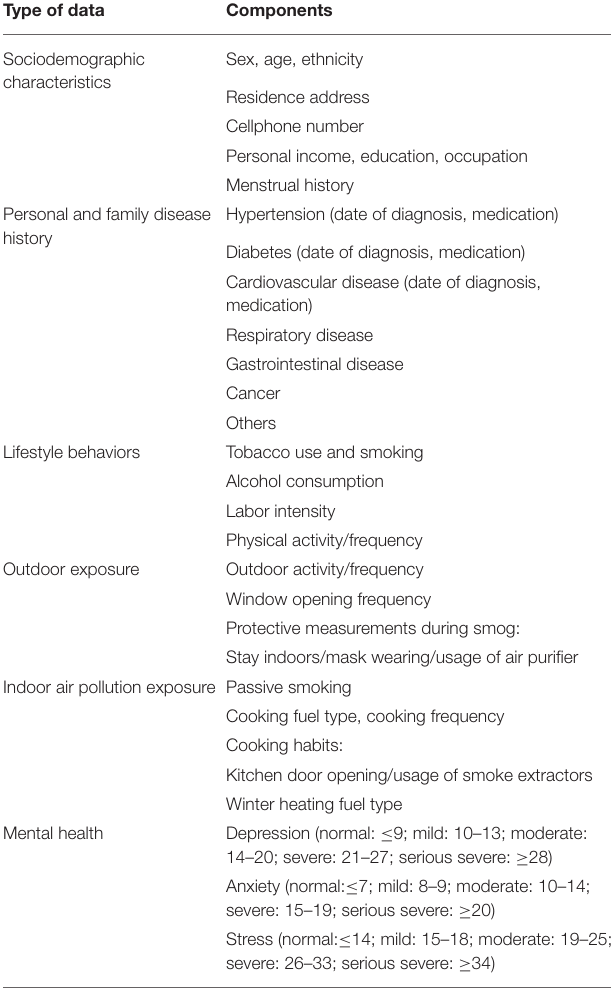
TABLE 2 | Sections and topics of the questionnaire. Type of